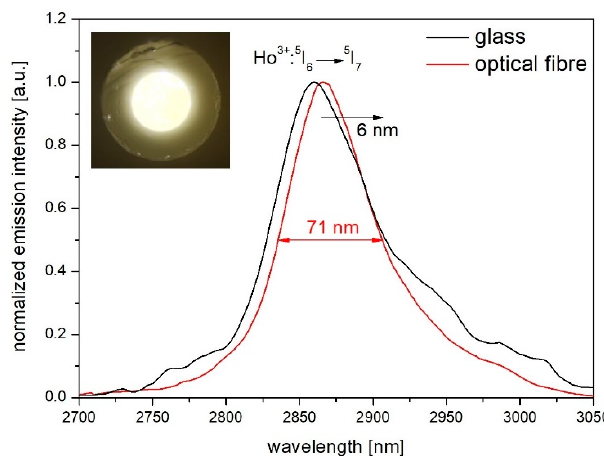
Figure 8. Obtained normalized mid-infrared luminescence spectra and cross section of developed optical fibre (inset).